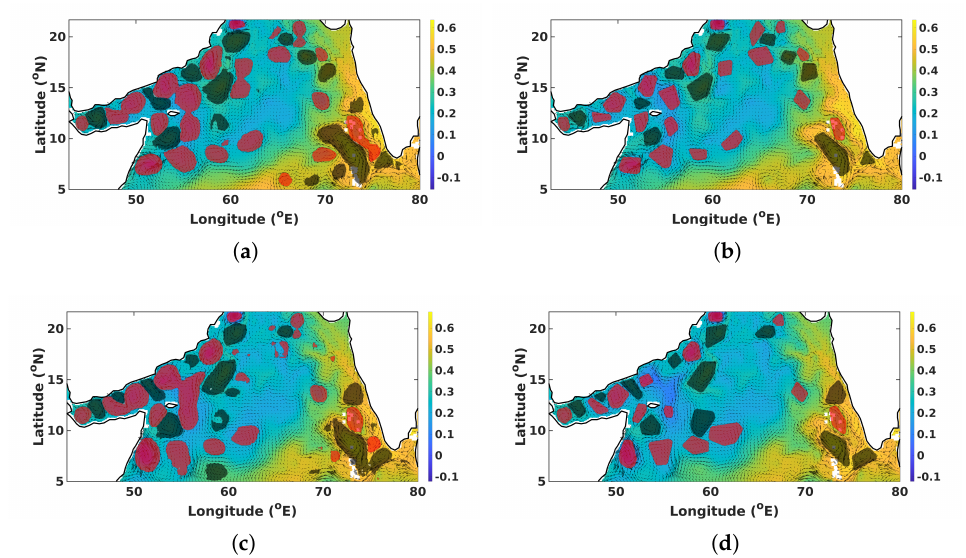
Figure 3. Ground − truth and predicted segmentation masks for the U-Net–PSPnet deep neural network using all five ocean-surface fields. The segmentation maps superpose the SSH data and the surface-velocity vectors. The plots demonstrate that the network captures all the labeled eddies with smoother boundaries. Here, the cyclonic eddies are colored red and the anticyclonic eddies are colored black. The color bars at the sides of each panel indicate the SSH values in meters; ( a ) Prediction—Sample 1; ( b ) Ground Truth—Sample 1; ( c ) Prediction—Sample 2; ( d ) Ground Truth—Sample 2.